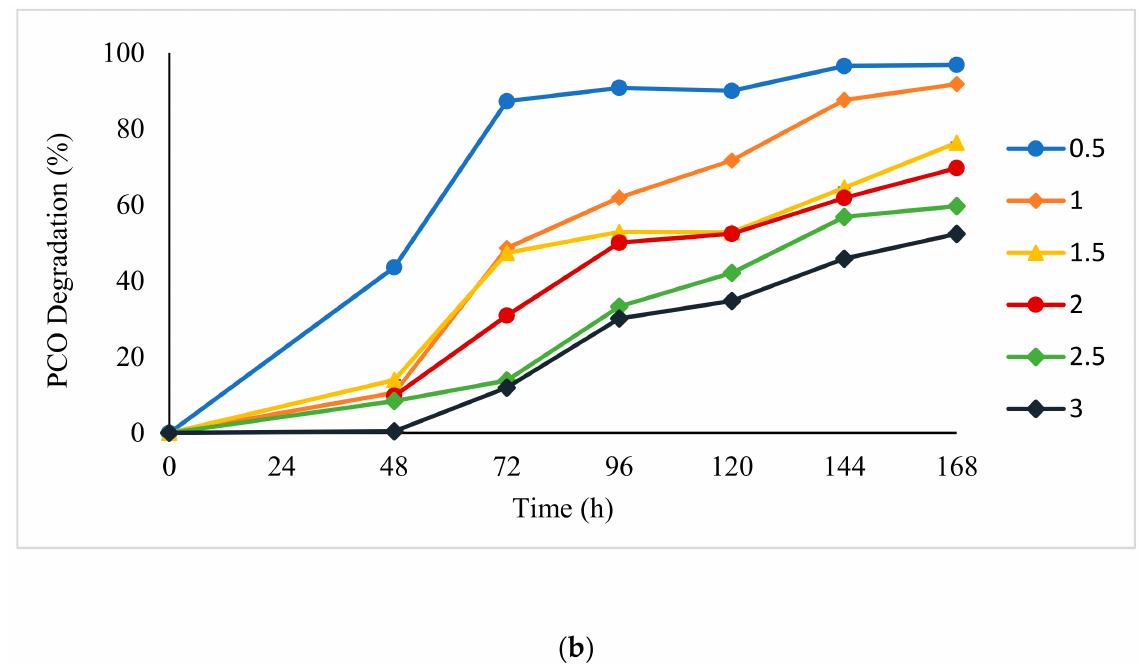
Figure 1. Effect of initial substrate concentration on degradation of ( a ) WCO and ( b ) PCO by BS14 bacterial consortium. Error bars represent mean ± standard error (SEM) and are contained within the points.